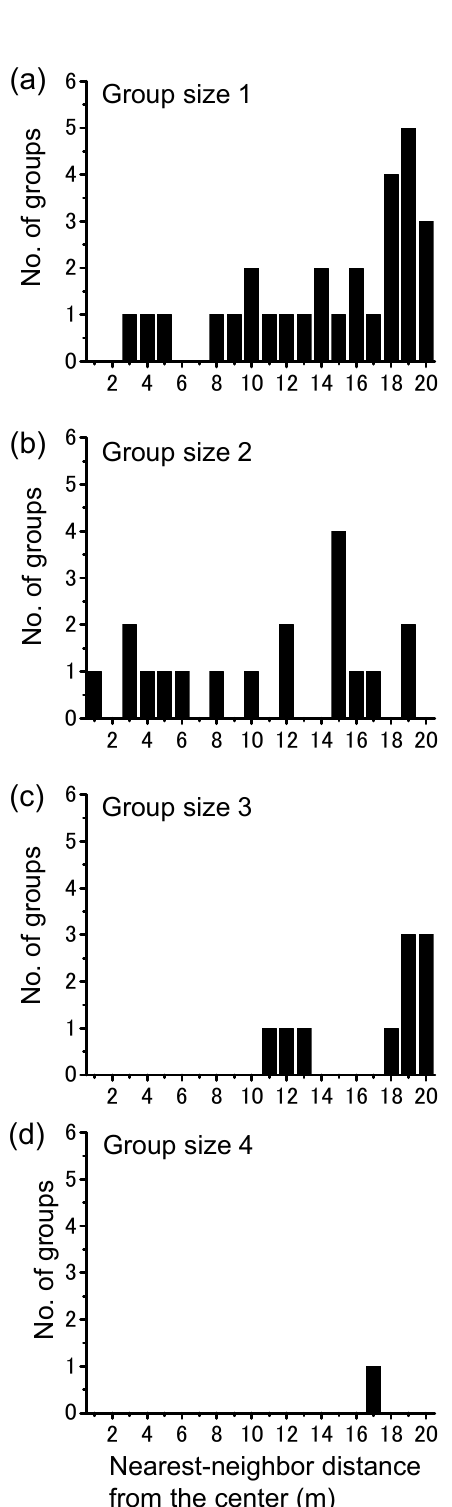
Figure 4. Distribution of various locust group sizes: ( a ) 1 (<10 locusts); ( b ) 2 (10–100); ( c ) 3 (100–1000); and ( d ) 4 (1000–10,000) associated with distance (m) from the center plant containing the largest aggregation. Group size 5 (>10,000 locusts) was not observed. Note that large groups other than the main group were not distributed near the center.